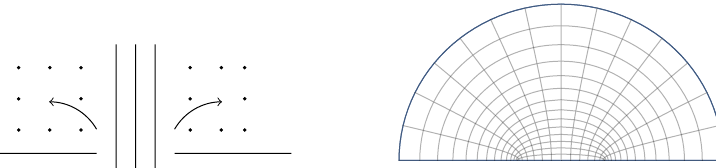
Figure 3 . Illustration of ( left ) how a higher number of degrees of freedom are available on each side of a constriction, to a flow passing through, and ( right ) the suggested elliptic (one-sided) solution to the geodesics, disregarding smoothness and edge effects at the connecting line.